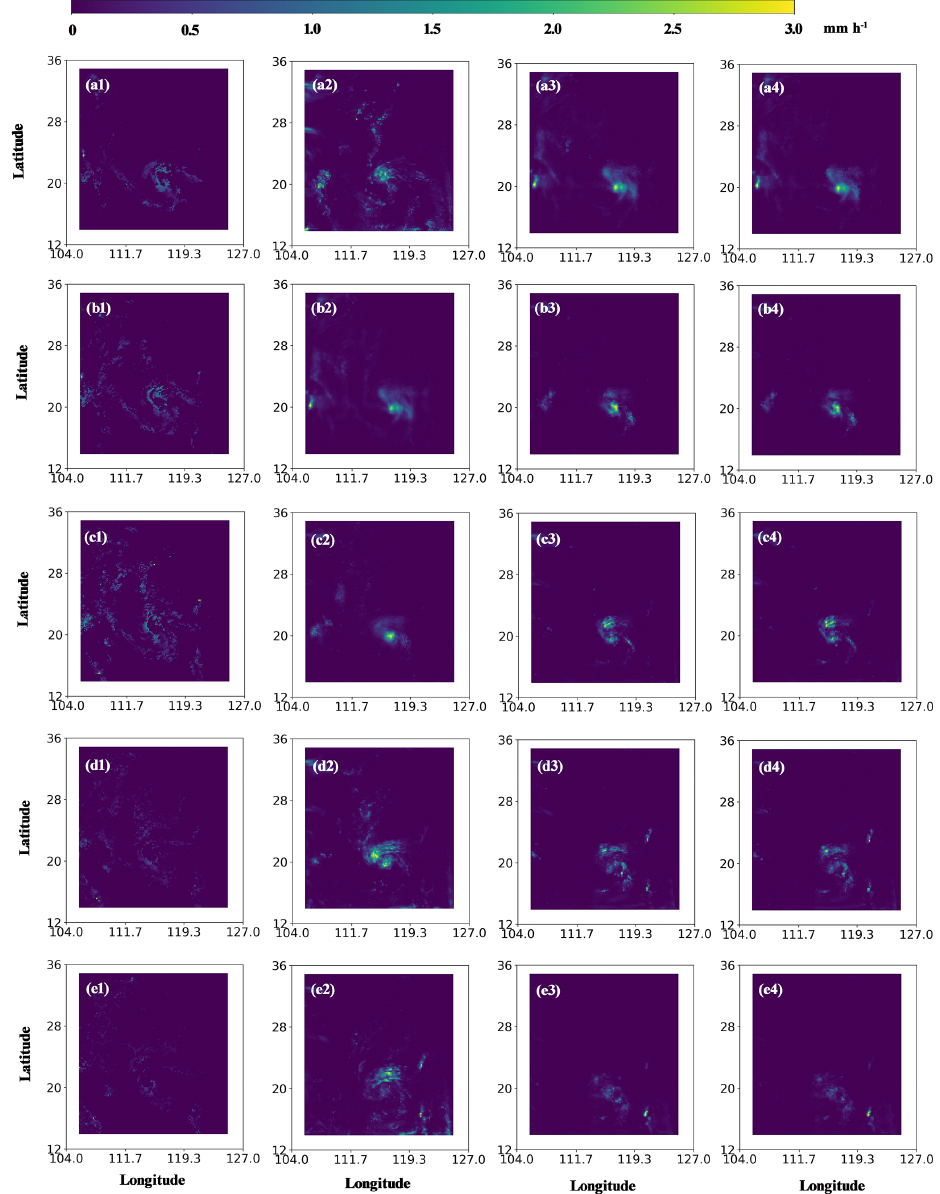
Figure 15. Time evolution of the rain rate for the nature run (column 1), control run (column 2), first-guess forecast of Exp-01 (column 3), and Exp-11 (column 4). From top to bottom, the row panels correspond to the results for 02:00–02:10, 04:00–04:10, 06:00–06:10, 08:00–08:10, and 10:00–10:10UTC on 18 August